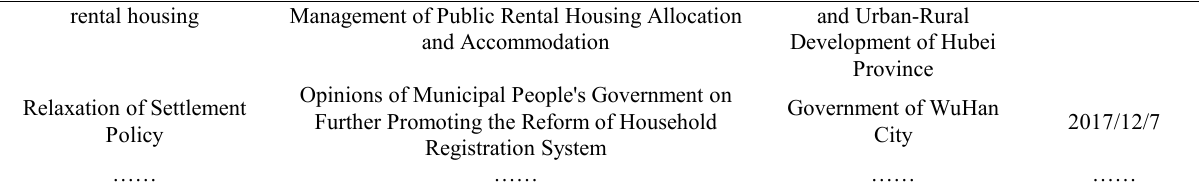
Table 1. Sample policy data information